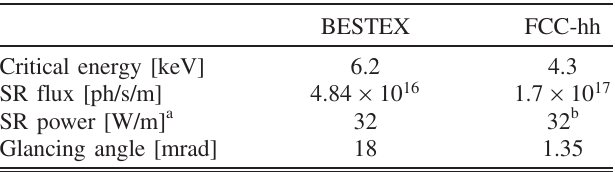
TABLE I. Comparison of the BESTEX (for the configuration of this specific work) and the FCC-hh relevant baseline